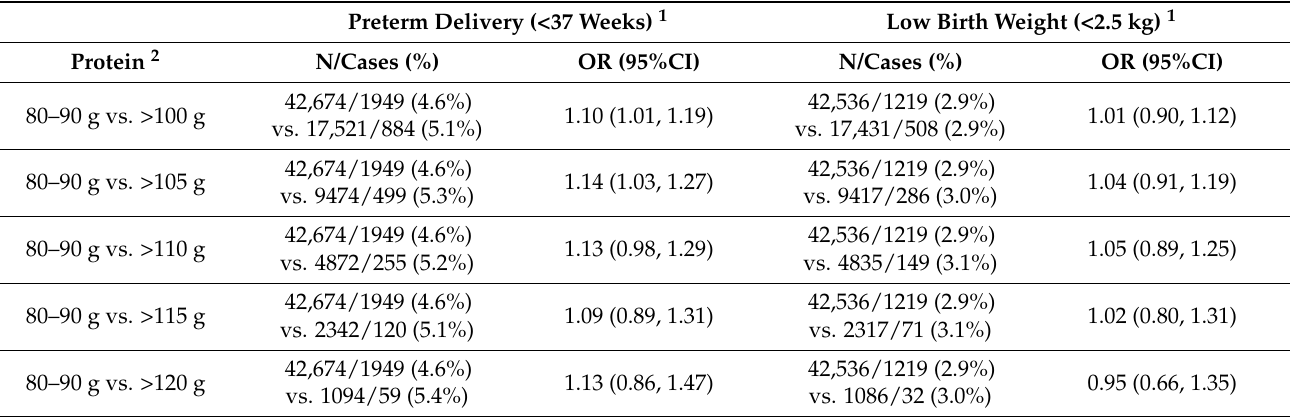
Table 5. Extreme protein intake in relation to preterm birth and low birth weight. The associations are presented in terms of odds ratios (ORs) using the 80–90 g category as the reference. The Danish National Birth Cohort (DNBC, 1996–2002) and the Norwegian Mother, Father and Child Cohort study (MoBa,